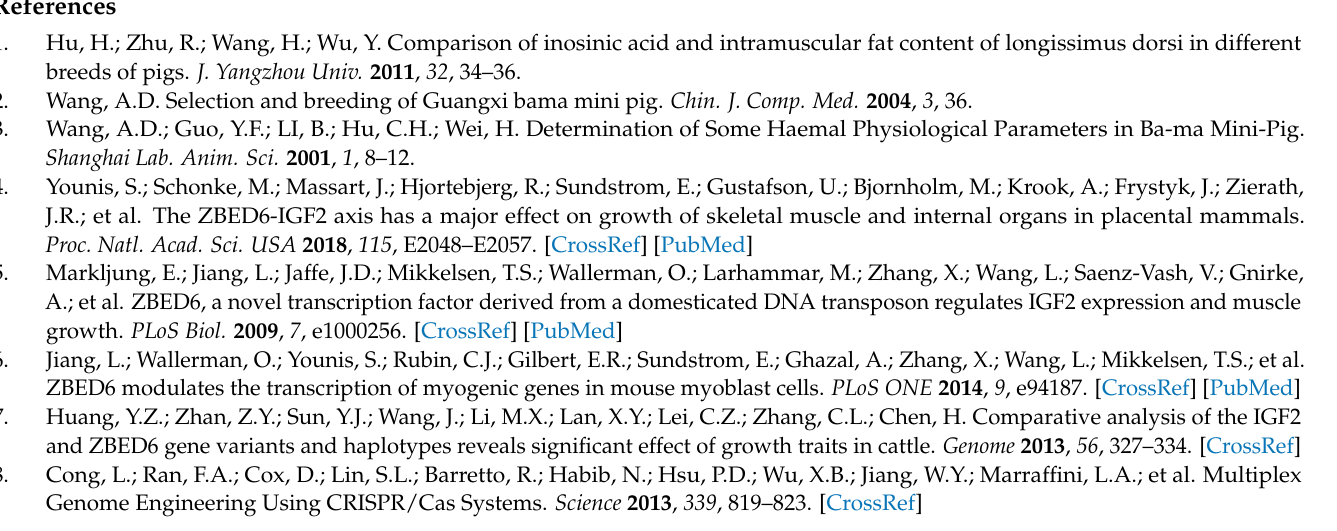
lncRNAs, Figure S4: Verification of candidate genes in F3 generation pigs. Table S1: A list of primers, Table S2: The quality analysis of sequencing data, Table S3: The genome mapping of sequencing data, Table S4: A expression of all lncRNAs, Table S5: A list of all differentially expressed genes, Table S6: Potential related genes of differentially expressed lncRNA, Table S7: A enrichment analysis of